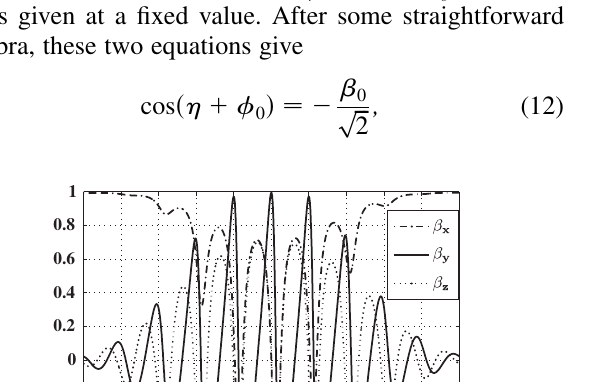
(cid:8) (cid:8) x , y , and z are the